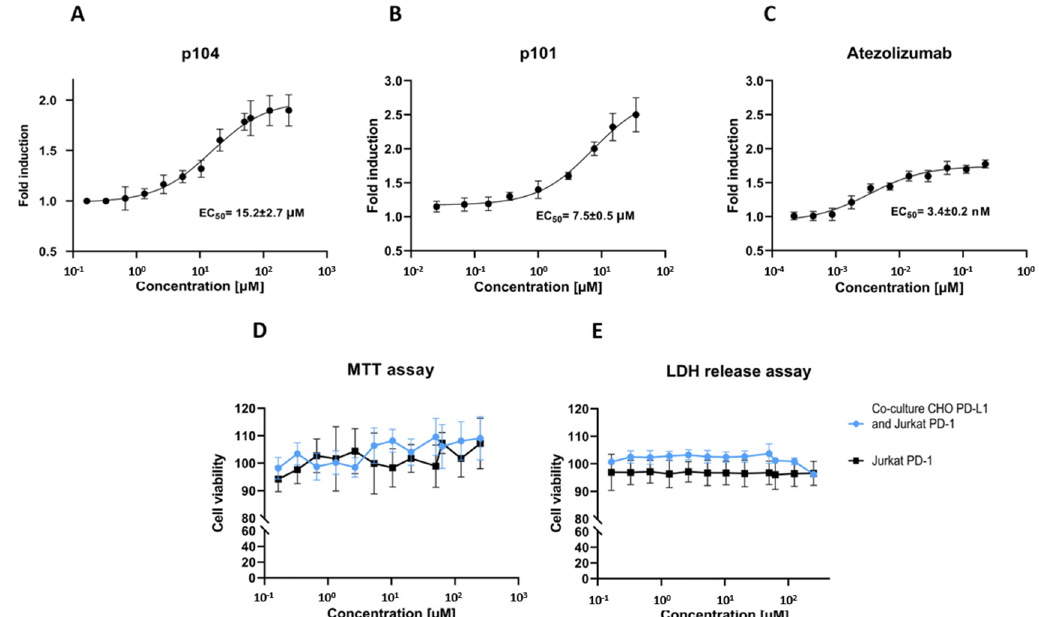
Figure 2. Macrocyclic peptide 104 inhibits PD-1/PD-L1 interaction in the cellular environment. The Jurkat cell line overexpressing PD-1 and carrying the NFAT-driven luciferase reporter was contacted with CHO-K1 cells stably overexpressing the TCR activator and PD-L1, and the activity of the reporter was monitored at varying concentrations of ( A ) p104, ( B ) p101, or ( C ) control antibody (atezolizumab). Atezolizumab and the tested macrocycles increase luciferase production (as determined by the increase in the luminescence level), indicating abrogation of PD-L1-mediated inhibition of TCR-induced Jurkat cell activation. The effect is dose-dependent. Half-maximal effective concentrations (EC 50 ) were calculated by fitting the Hill equation to the experimental data. ( D , E ) Effect of p104 on cell viability determined with the MTT assay ( D ) and LDH release ( E ). The data are shown as mean ± SD from three independent experiments normalized to the control (vehicle-treated cells).